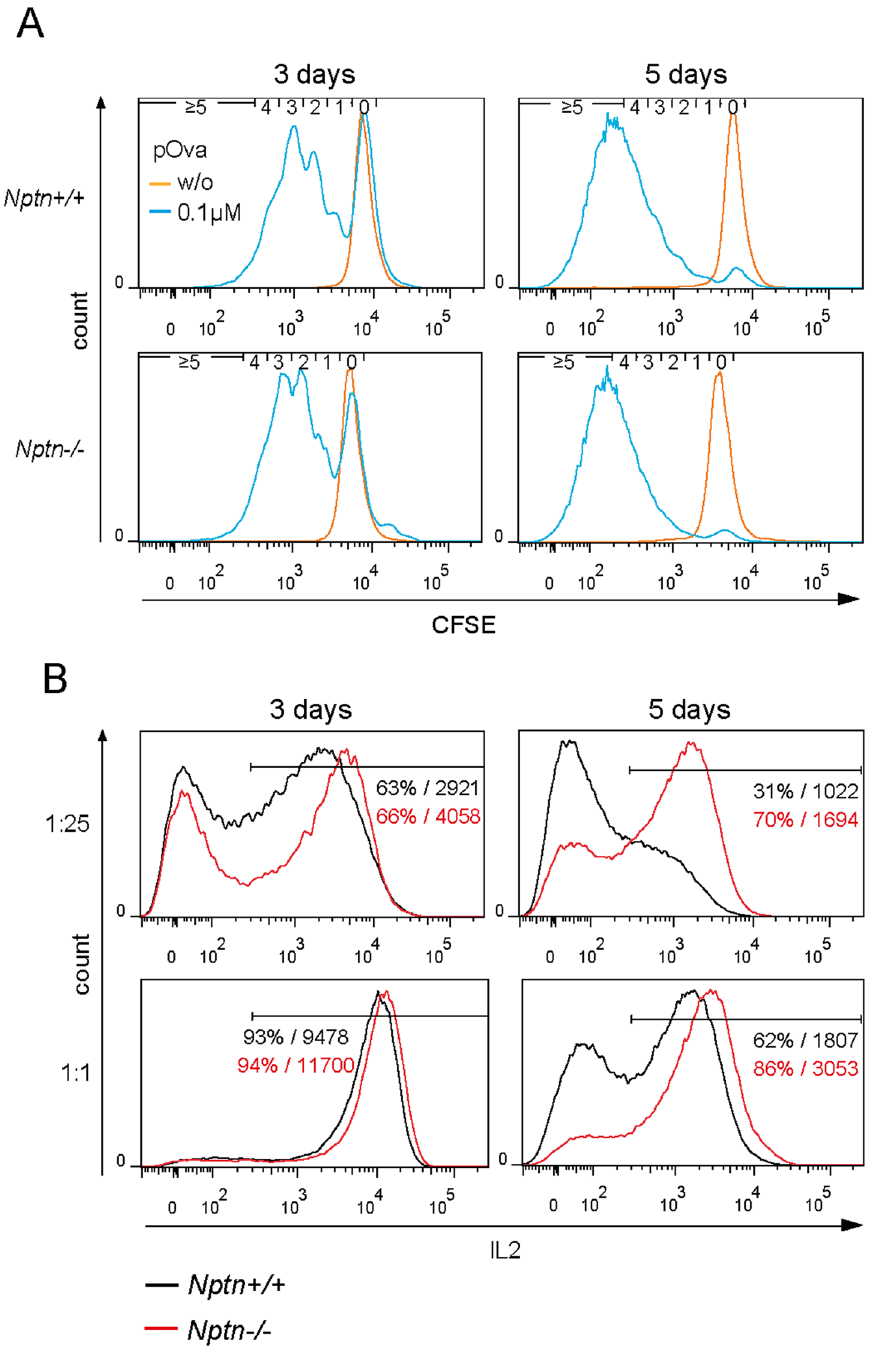
Figure 3. Antigen-induced IL2 production is facilitated in Nptn − / − T cells. ( A ) Proliferation upon antigen- specific T cell stimulation. 1 × 10 5 OT-II transgenic wt or Nptn − / − CD4 T cells were cocultured for 3 or 5 days together with 4 × 10 3 (1:25) dendritic cells (DCs) which had been loaded either with 0.1 µ M pOva or were left unloaded. Proliferation of T cells was analyzed flow cytometrically by CFSE dilution. T cells and DCs were distinguished based on CD4 and CD11b labeling, respectively. Histograms represent results from one of two independent experiments. Small numbers indicate number of completed cell cycles. ( B ) Production of IL2 by OT-II transgenic T cells cocultured with DCs as described above with DC: T cell ratios of 1:25 or 1:1, respectively, was measured by intracellular FACS. Representative histograms show IL2 fluorescence intensities from one of two experiments. Numbers indicate proportions of IL2 producing T cells and mean fluorescence intensity of IL2 within the IL2 positive